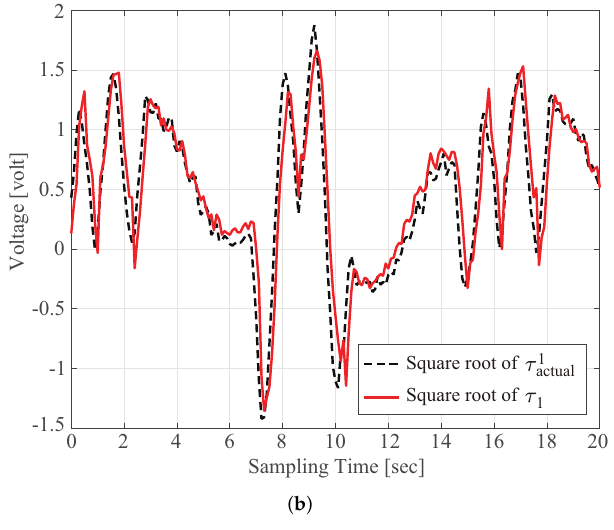
Figure 3. Measured actual torque τ 1 is compared with ( a ) torque τ (1) calculated using the param- actual eters listed in Table 1 and ( b ) torque τ 1 ( k ) computed using (26) with the estimated parameters in (36). ( a ) The behavior of τ 1 ( k ) computed using (1) with the parameters listed in Table 1. ( b ) The behavior of τ 1 ( k ) computed using (26) with the parameters listed in